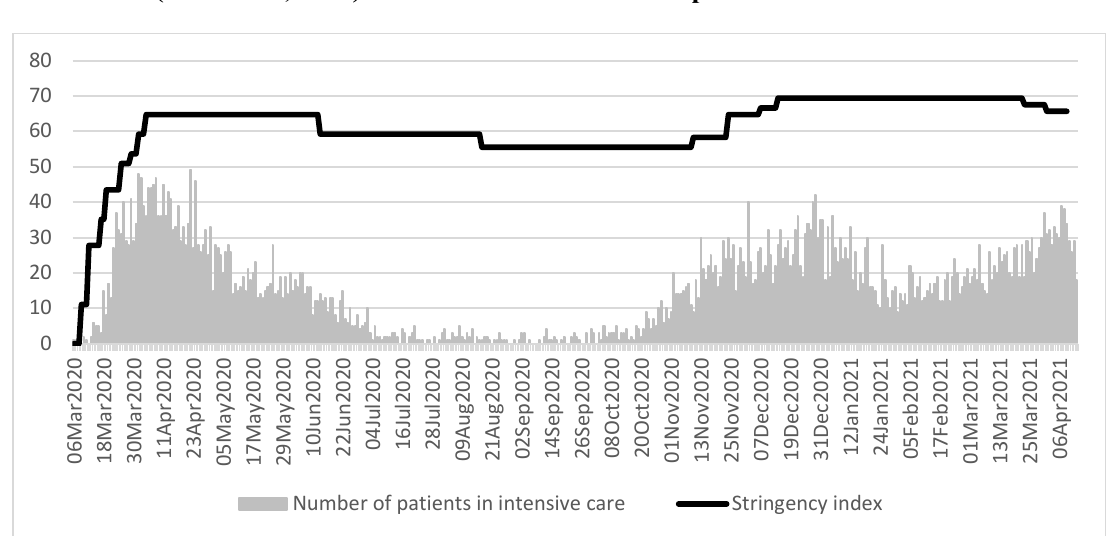
Figure 1: Number of patients in intensive care with COVID-19 (Folkhälsomyndigheten, 2021) and Oxford COVID-19 stringency index* ( Hale et al., 2021) between March 2020 and April 2021 in